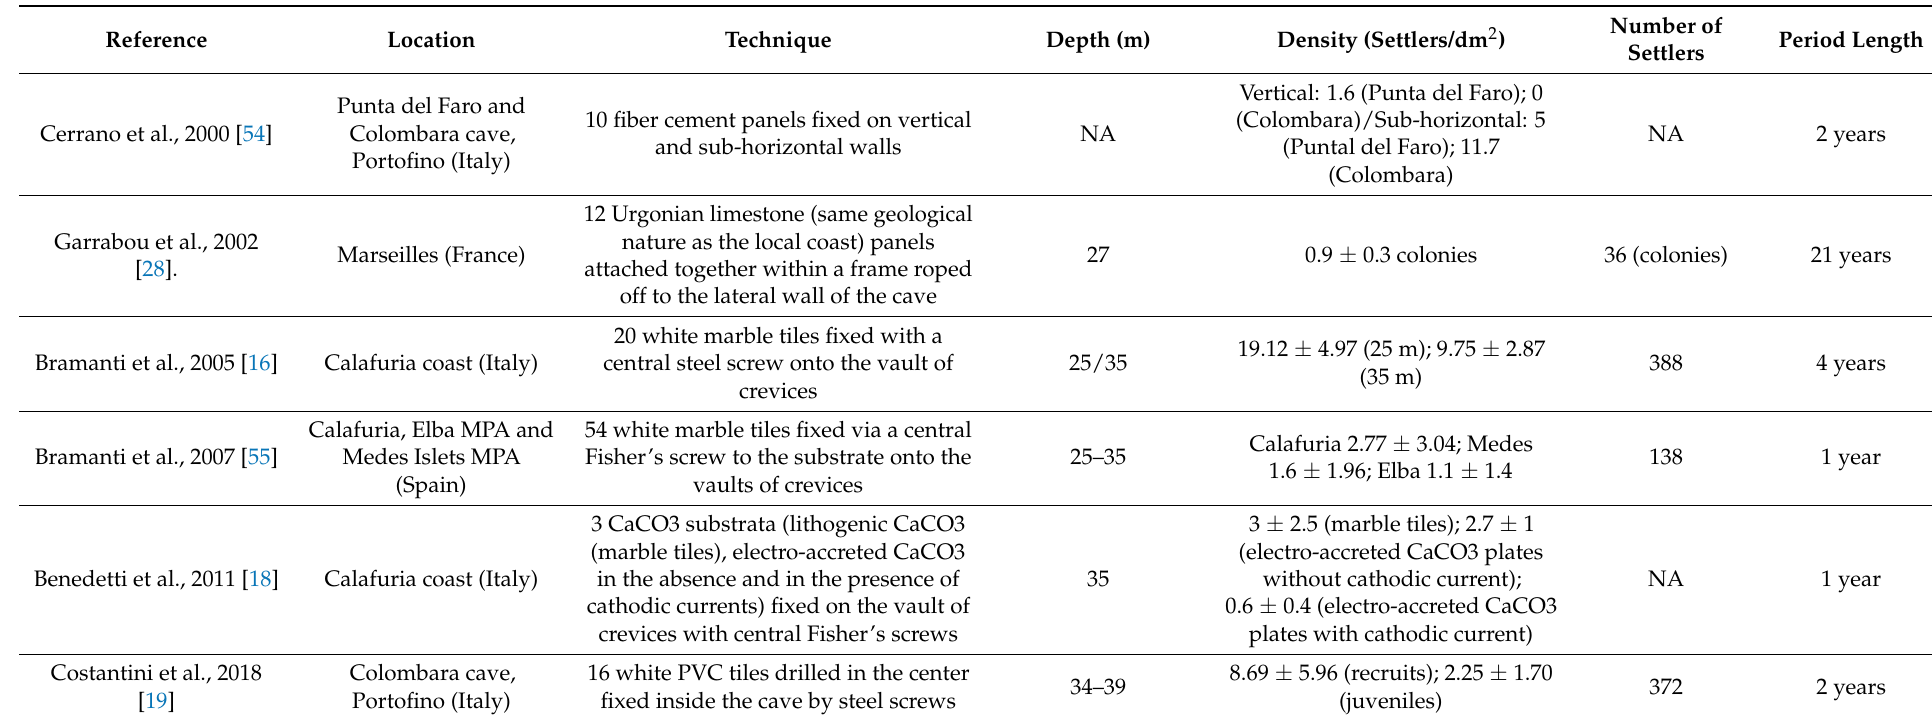
Table A2. List of articles considered to summarize C. rubrum larval enhancement experiments on